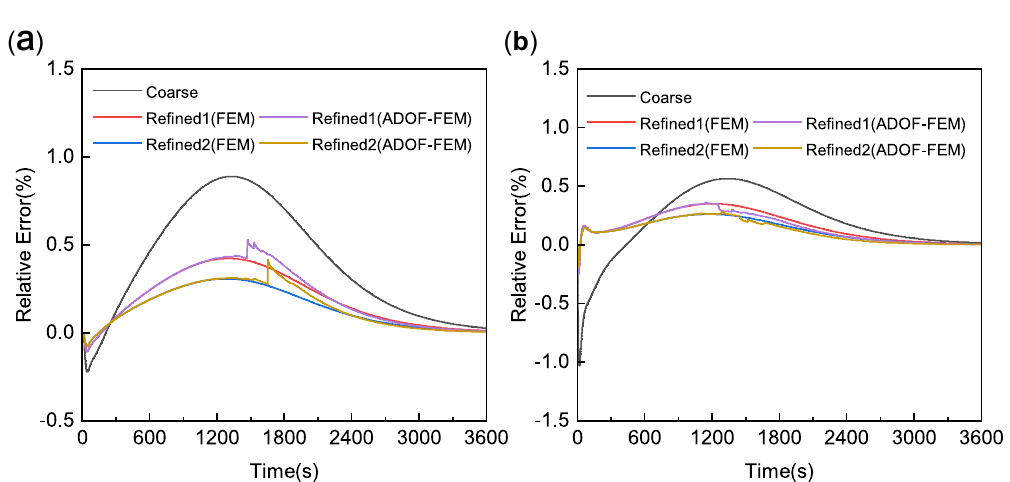
Figure 4. Relative error at typical positions of Example 1: ( a ) relative error at position (50,0). ( b ) Rela- tive error at position